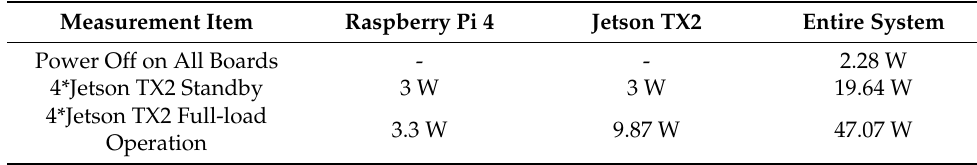
Table 2. System Power